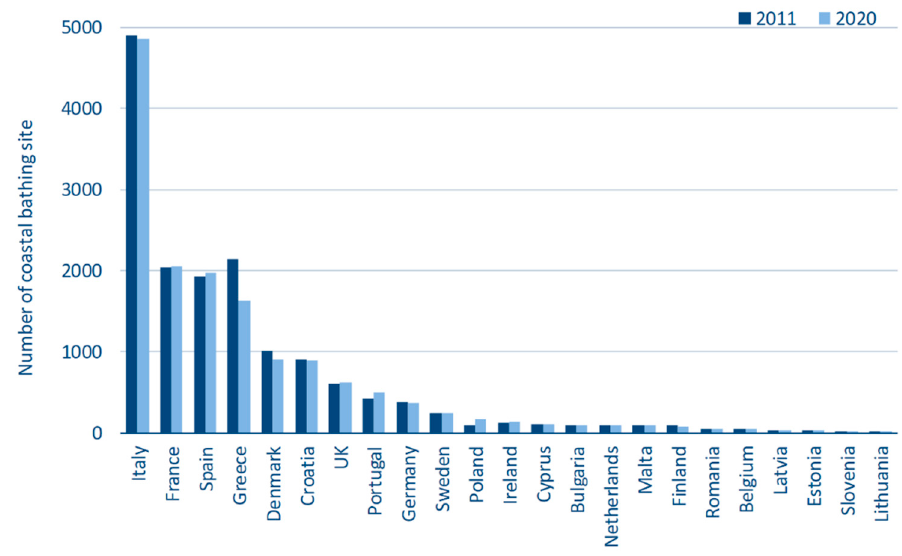
Figure 7. The number of coastal bathing sites in EU in the 2011 and 2020 bathing seasons.